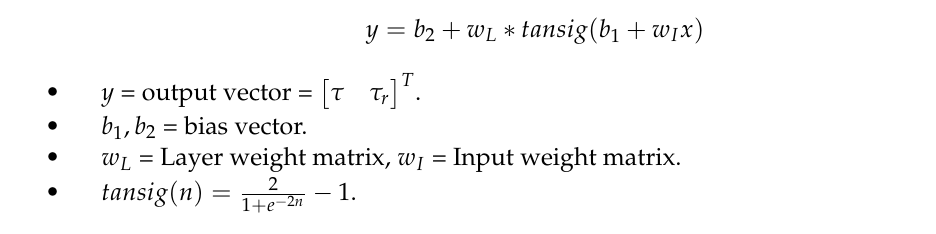
N , F z = 100 N 7 7